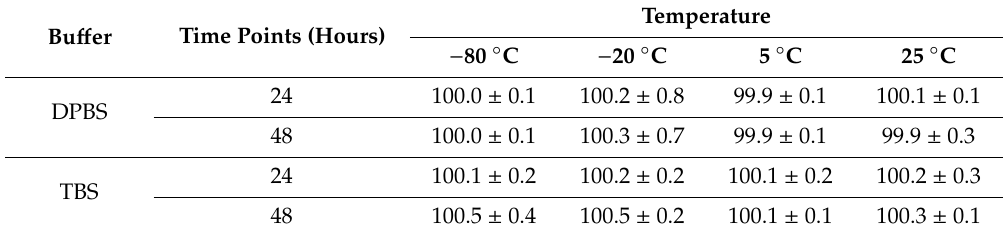
Table 3. Recovery of CSP7 acetate in bulk solution after storage at di ff erent temperatures.